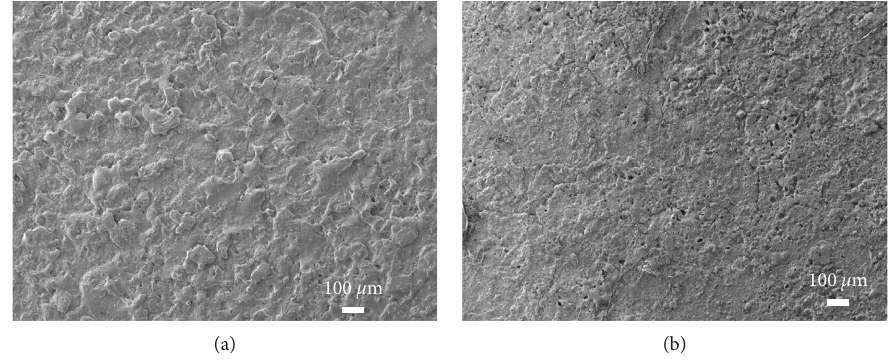
Figure 6: Microstructure of the coating under different capacitances. (a) 1st grade. (b) 5th grade.